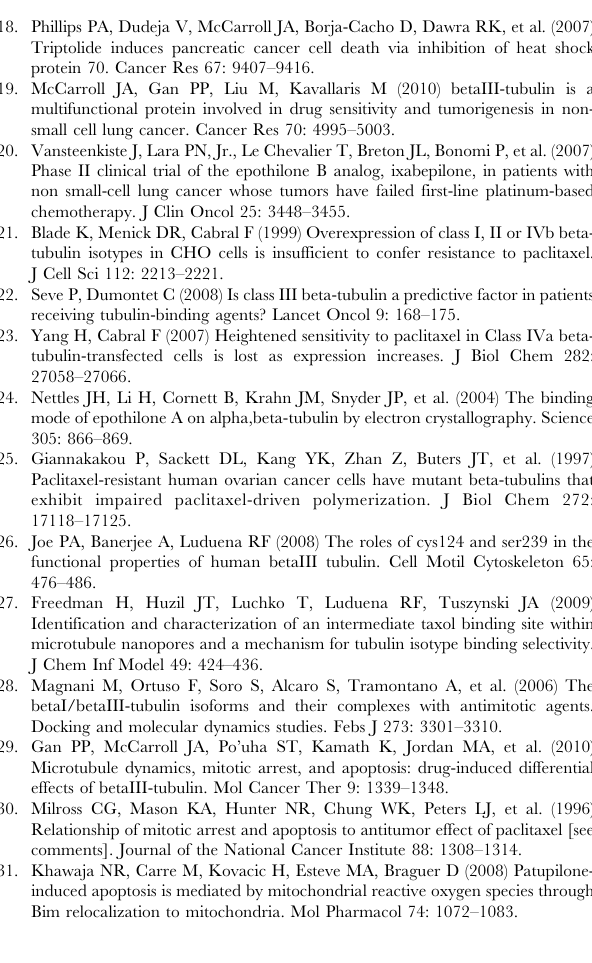
cells treated with control siRNA or Mock (lipofectamine 2000 only). No significant changes in the expression of other b -tubulin isotypes were observed. Glyceraldehyde-3-phosphate dehydroge- nase ( GAPDH ) expression was used as a loading control. Representative gels. n = 3 separate experiments. Figure S2 Stable and potent inhibition of b III-tubuin increases sensitivity to epothilone B in H460 NSCLC cells. Clonogenic assay showing the effect of stable knockdown of b III-tubulin on sensitivity to epthoilone B in H460 cells expressing shRNA targeting b III-tubulin (pRS/ b III SH4 ) (dashed line) or control (pRS/Ctrl SH2 ) (solid line). Points , means; bars SE (n= 6 individual experiments,*p , 0.01). Figure S3 Effect of b II-, b III- and b IVb-tubulin knock- down on the microtubule network. Calu-6 transfected cells were fixed and stained with an antibody to a -tubulin after 72 h transfection. Arrows represent dying cells. Scale bar-20 m m.